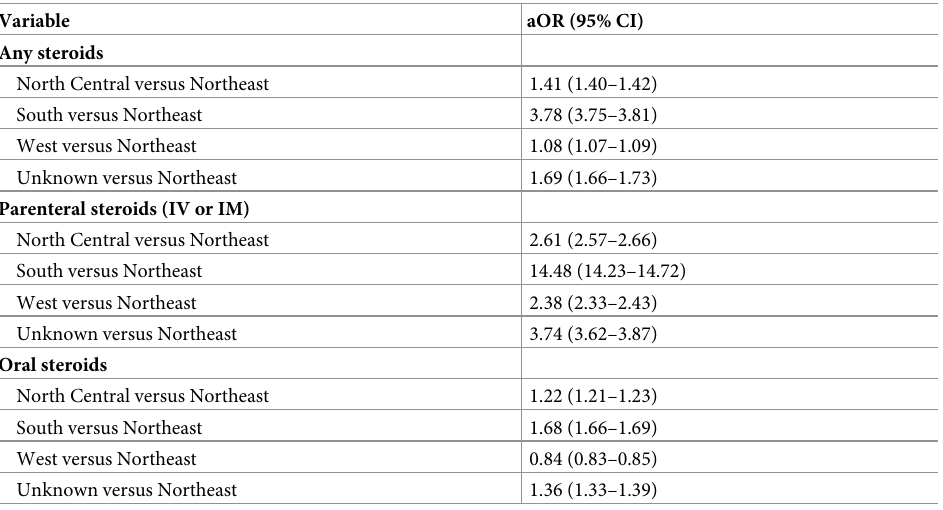
Table 3. Associations between geographical region and use of systemic